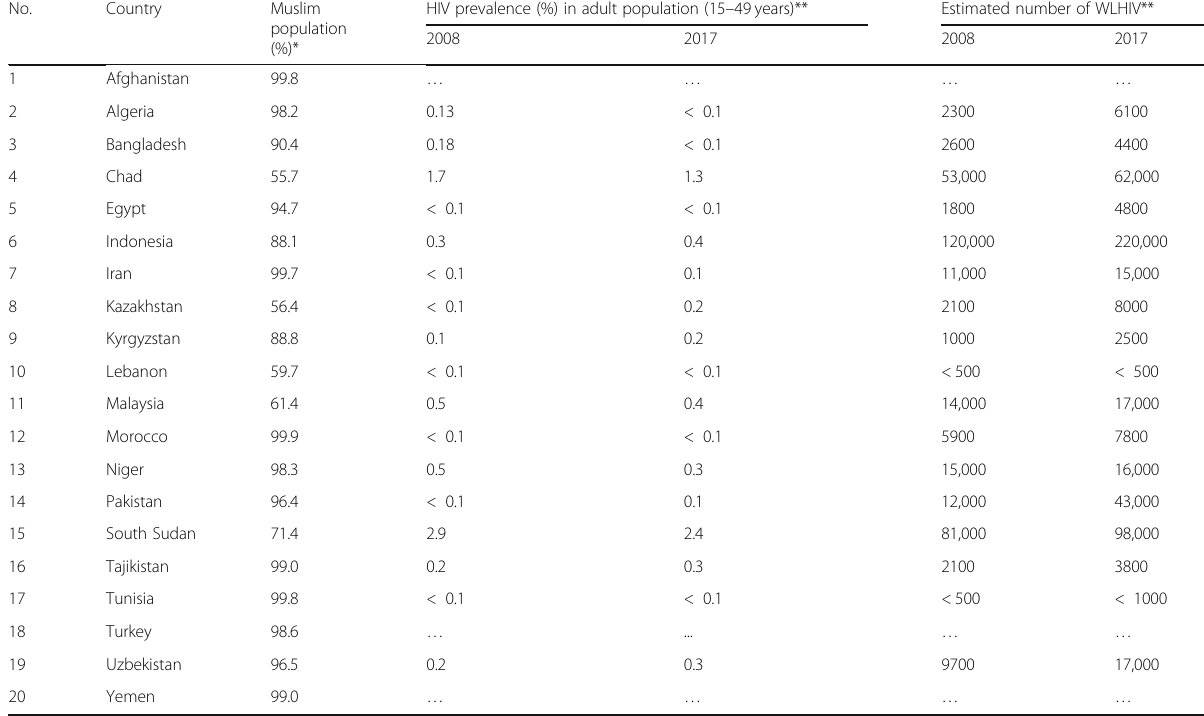
Table 1 Proportion of Muslim population, HIV prevalence, and number of WLHIV in the Muslim countries included in identifying potential articles. Adapted from Pew Research Centre (2011) and UNAIDS (2018)